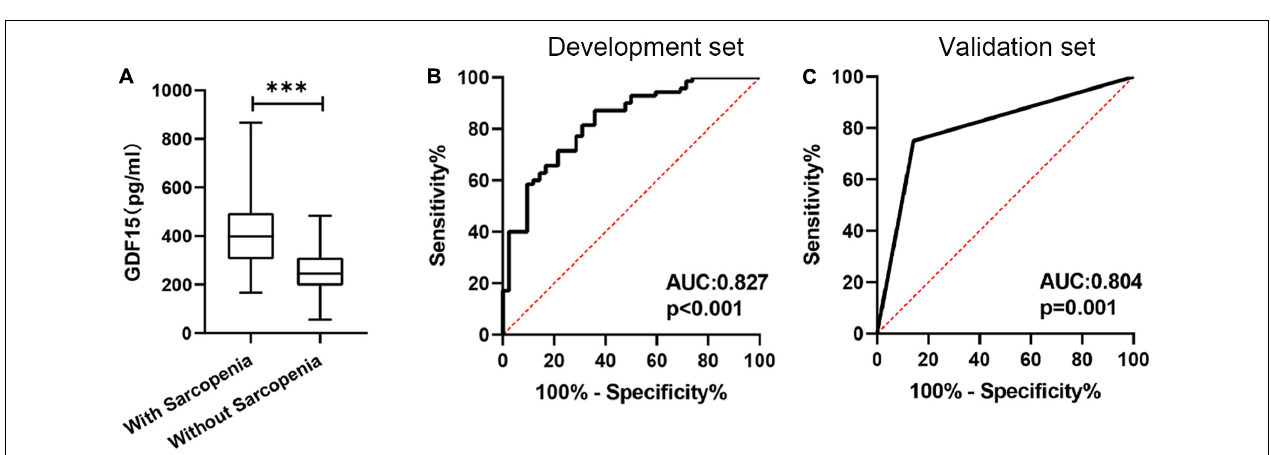
FIGURE 3 | The predictive value of the serum GDF15 level. (A) The serum GDF15 level differed between patients with sarcopenia and patients without sarcopenia; (B) receiver operating characteristic curve analysis of serum GDF15 level for the prediction of sarcopenia in the development set; (C) receiver operating characteristic curve analysis of serum GDF15 level for the prediction of sarcopenia in the validation set. ∗∗∗ p <